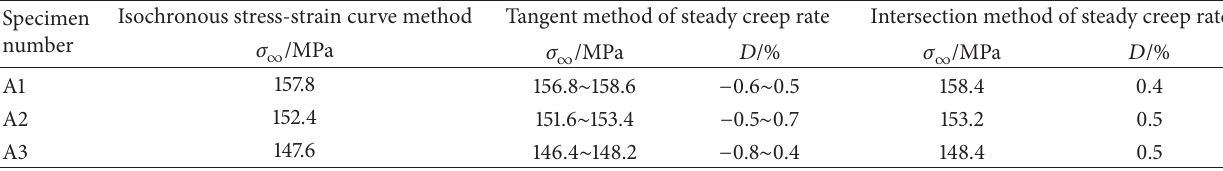
Table 3: Results comparison of the three methods to confirm the long-term strength. Specimen